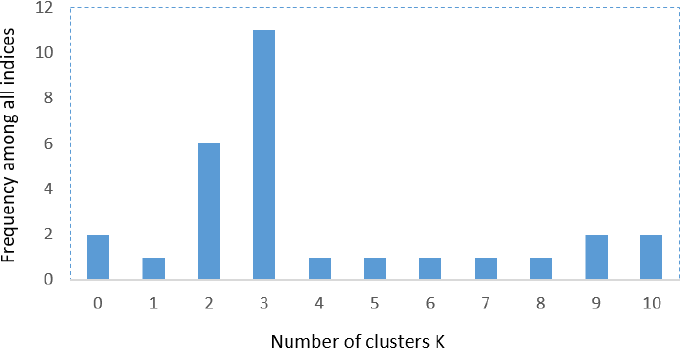
Figure 2. The optimal number of